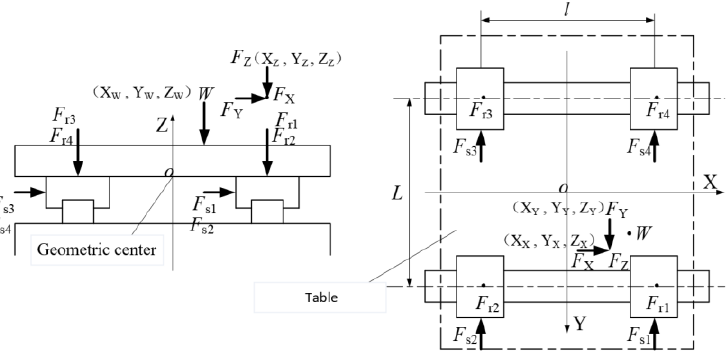
Figure 5. Load diagram of linear guide unit.